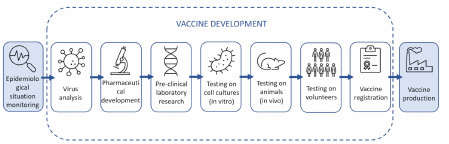
Figure 3. Vaccine development process in the context of the vaccine